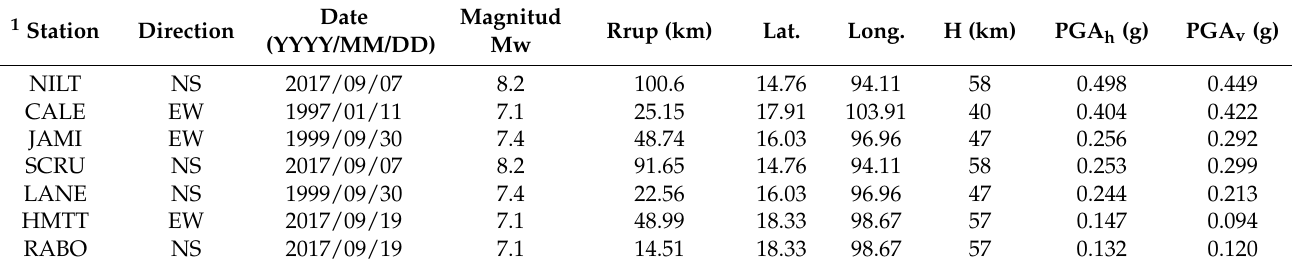
Table 1. Mexican ground motions used for the frames in Figure